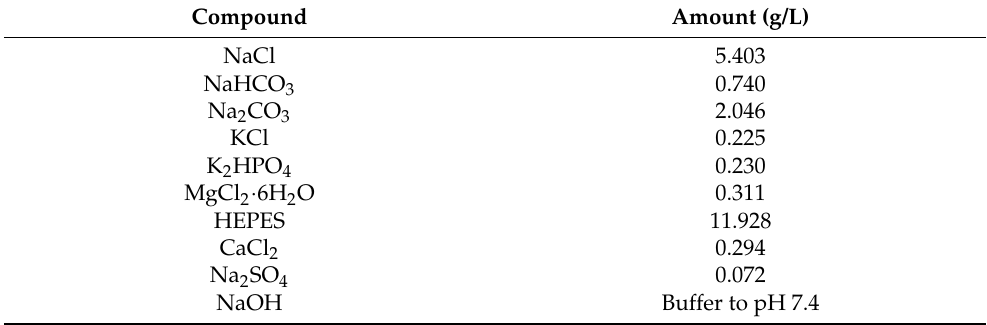
Table 1. Composition of the